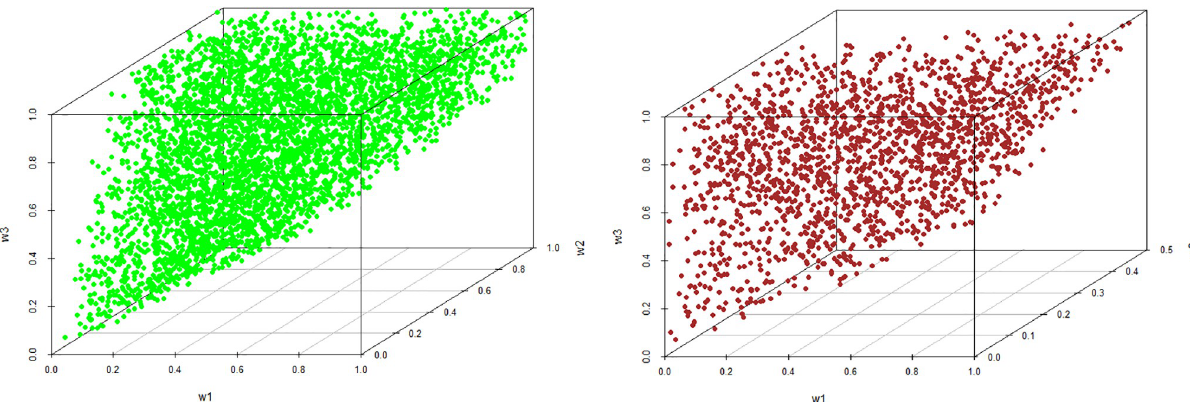
Fig 3. Weights of criteria if A4 is the best alternative (left) and A5 is the best alternative (right).